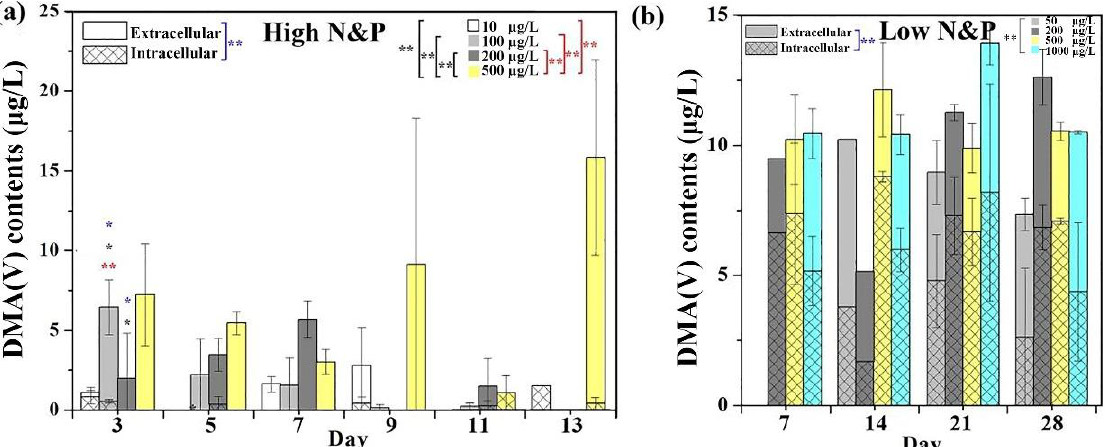
Figure 7. The intracellular and extracellular DMA(V) concentrations varied with incubation time that exposed different iAs(V) concentrations in the high ( a ) and low ( b ) nutrient sets. Note: Red and black * on the legend indicate significant variations of intracellular and extracellular DMA(V) con- centrations with incubation time, respectively, between each of two groups of ambient iAs(V) con- centrations; blue * indicates significant variations between intracellular and extracellular DMA(V) concentrations in four groups of ambient iAs(V) concentrations. Red, black, and blue * on column bars indicate significant variations of intracellular, extracellular, and total DMA(V) concentration with incubation time. Significance levels below 0.05 (*) and 0.01 (**) are denoted in the figure.